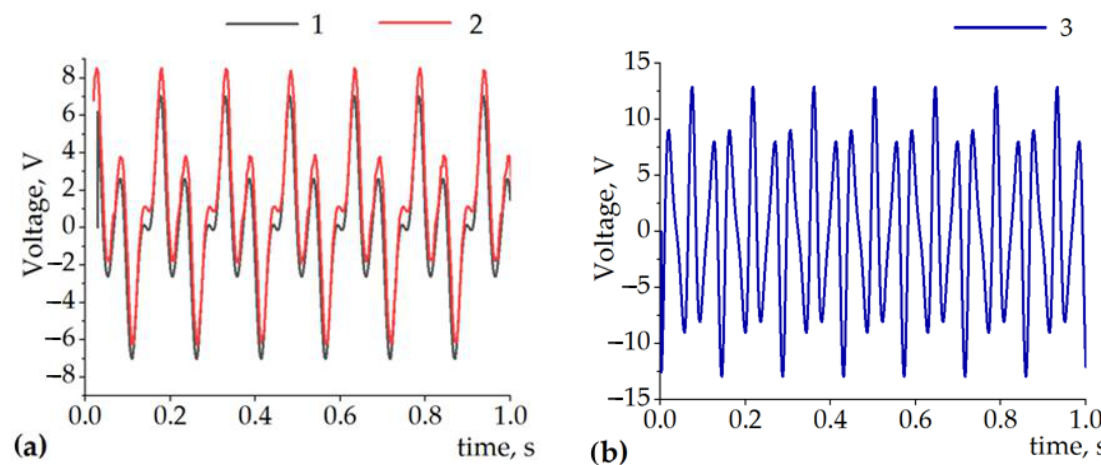
Figure 4 . ( a ) 1 — measured and 2 — simulated (shifted + 1 V) output of a single coil when T = 18 mm, p = 12 mm, the amplitude of the sinusoidal excitation was 12.5 mm, and oscillating at 6.6 Hz.; ( b ) 3 — simulated voltage under equivalent conditions with T = 10 mm and p = 5 mm.